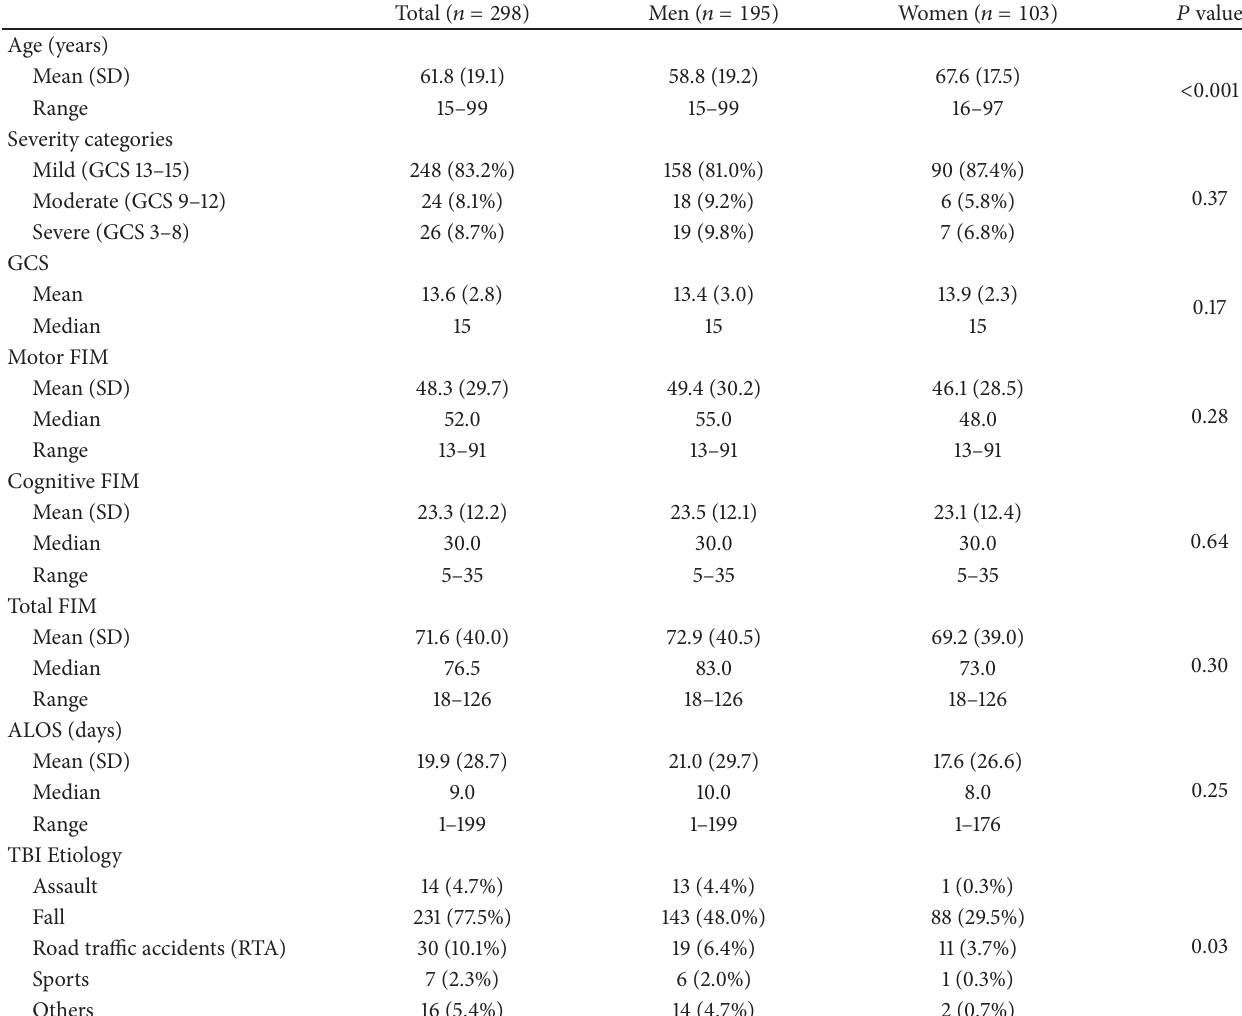
Table 1: Age, injury severity, etiology, and FIM scores in 298 men and women.